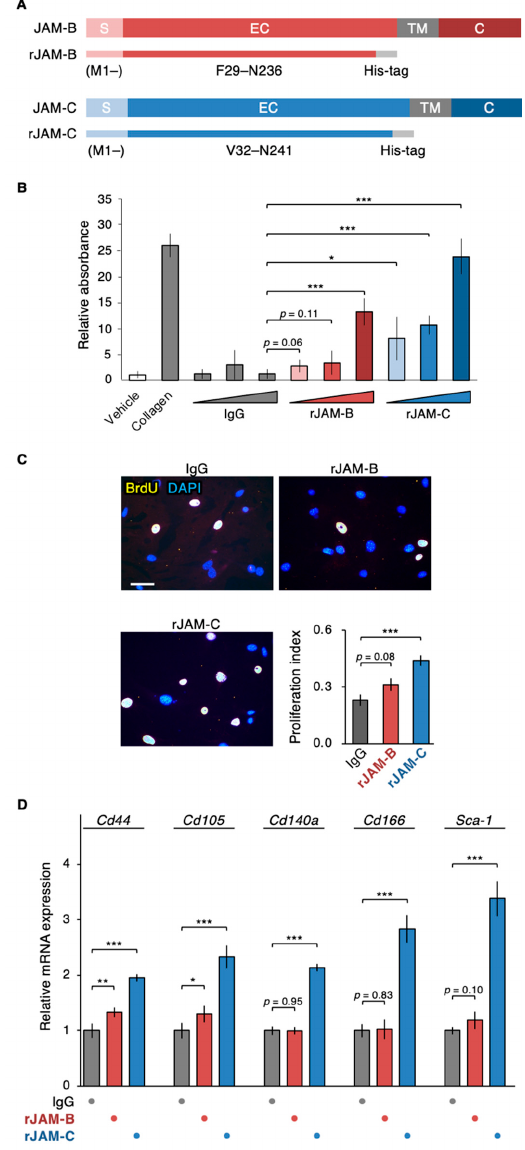
Figure 5. Soluble JAM-C functions as the niche for ADSCs. ( A ) Schematic illustration of recombinant JAM-B (rJAM-B) and rJAM-C. S, signal domain; EC, extracellular domain; TM, transmembrane domain; C, cytoplasmic domain. ( B ) Cell adhesion assay for ADSCs grown on culture dishes coated with the indicated proteins. The relative levels are shown in histograms (mean ± SD; n = 5). ( C ) BrdU assay for ADSCs grown on culture plates coated with the indicated proteins. The BrdU/DAPI levels are shown in histograms (mean ± SD; n = 12). Scale bar, 100 µ m. ( D ) RT-qPCR for the indicated MSC markers in ADSCs grown on culture dishes coated with the indicated proteins. The relative expression levels are shown in the histograms (mean ± SD; n = 4). * p < 0.05; ** p < 0.01; *** p <